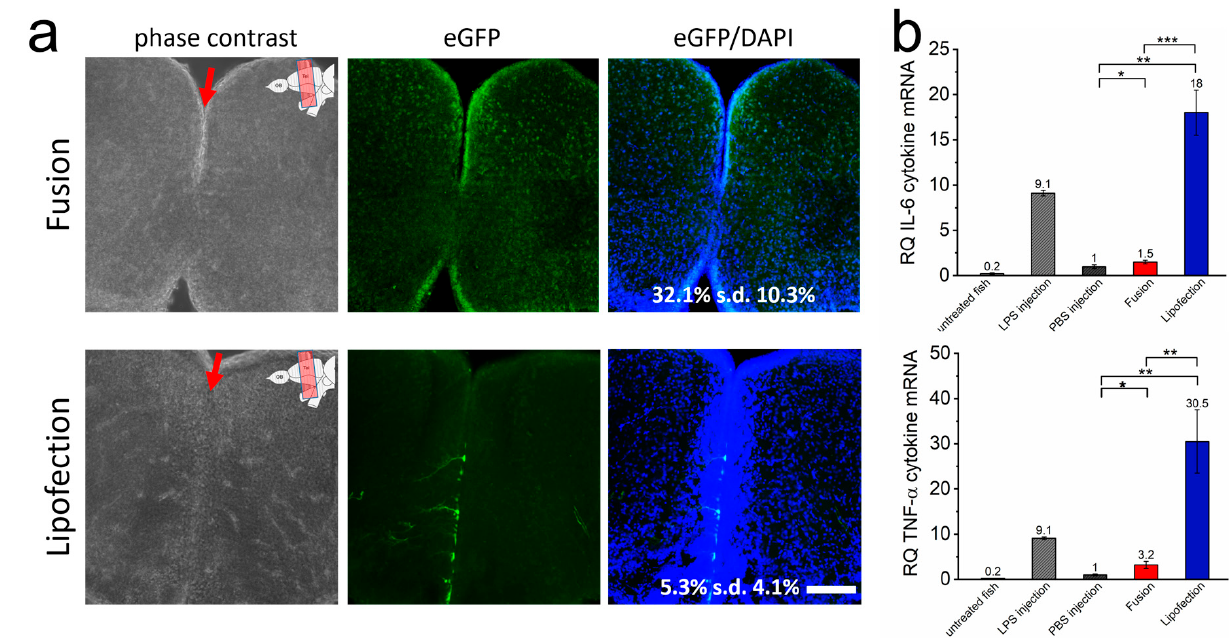
Figure 4. Endosome-independent transfer allows efficient transfection rates with low cytokine response in vivo. ( a ) The brain of adult zebrafish was injected with GFP-mRNA containing fusogenic liposomes (top) or dependent on endosomal uptake (lipofection, bottom). Injection into the ventricle is indicated by a red arrow, upper right of the image shows ventricular zone of zebrafish brain. A total of 24 h after nucleic acid transfer, whole brains were isolated and brain sections were stained for GFP (green) and nuclei (blue). Co-stained nuclei were counted as transfected cells and are given as percentage of all cells. The whole RNA of identically treated brains was isolated 24 h after nucleic